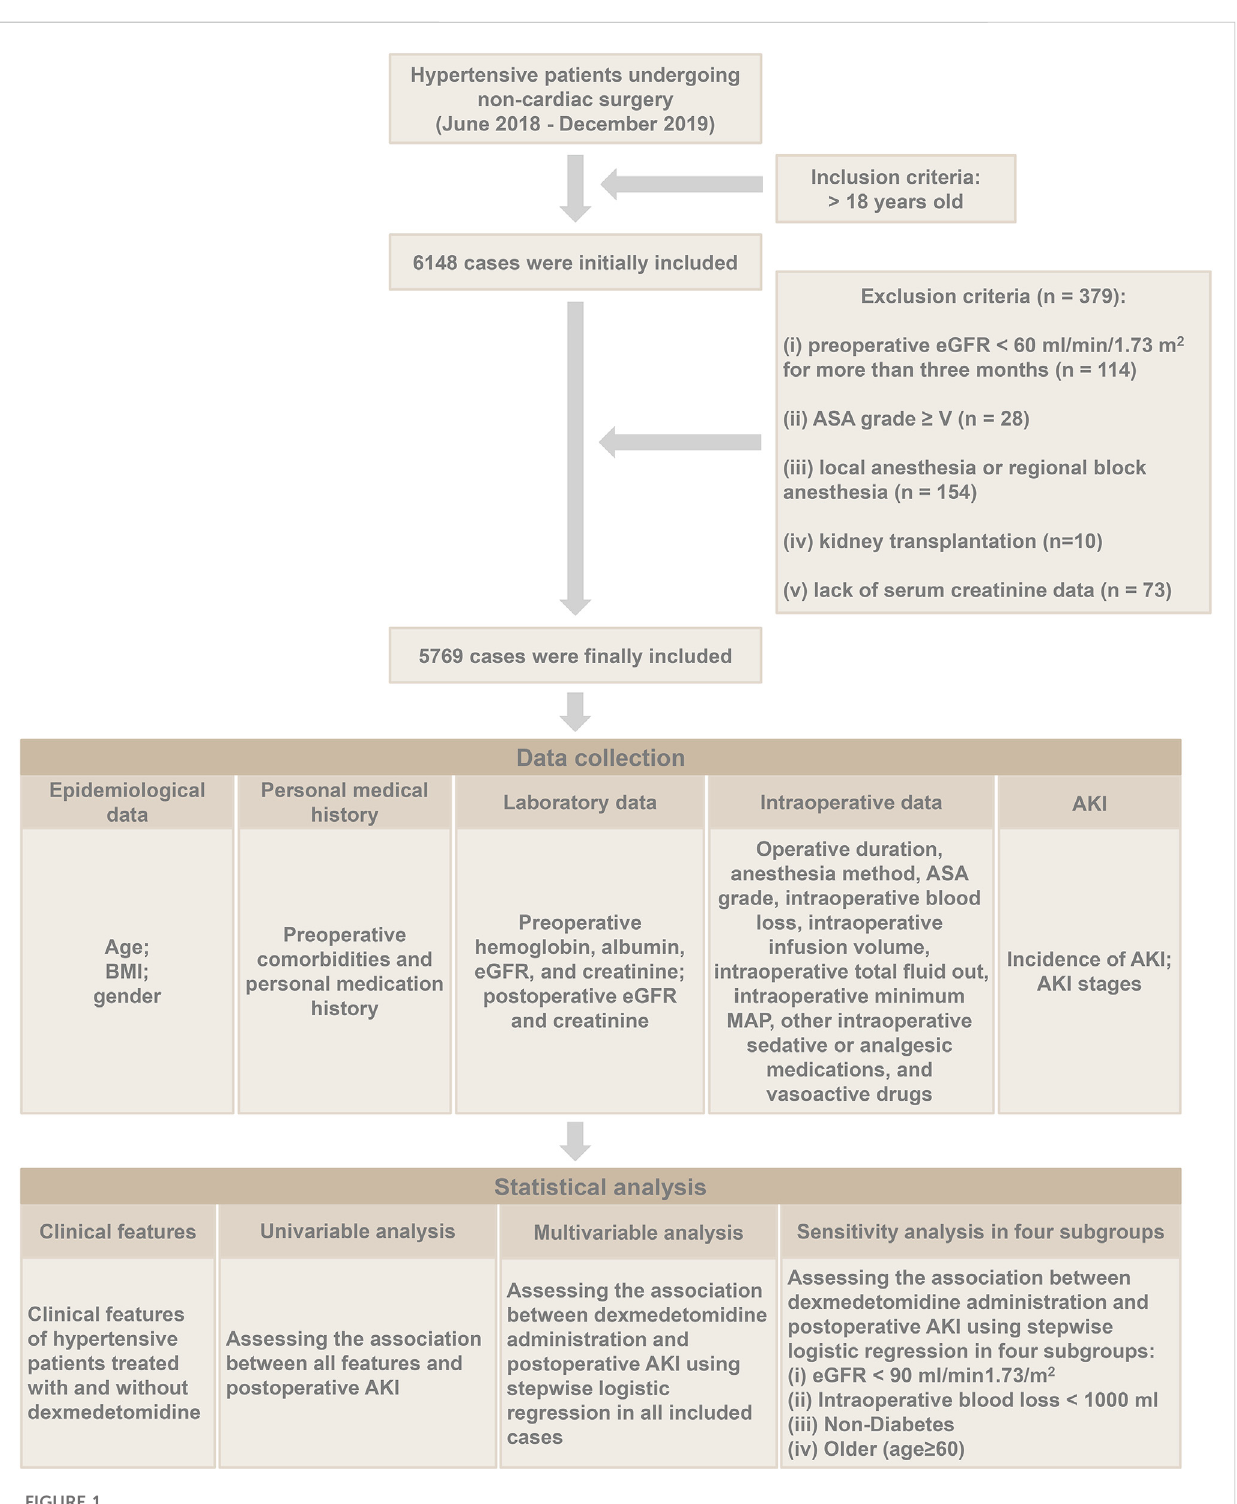
FIGURE 1 The general fl ow chart of this